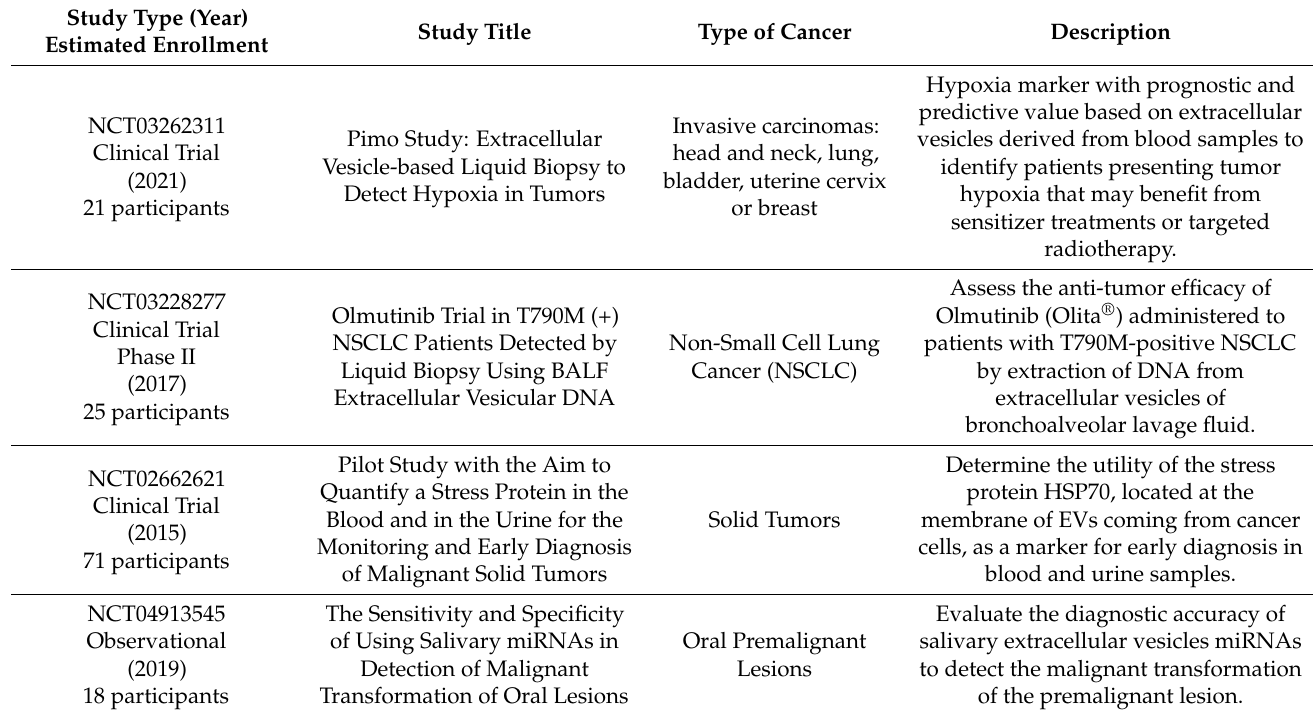
Table 3. Completed clinical trials utilizing extracellular vesicles as biological markers and the description of the circum- stances under which they are used. Information from ClinicalTrials.gov, accessed on 1 November